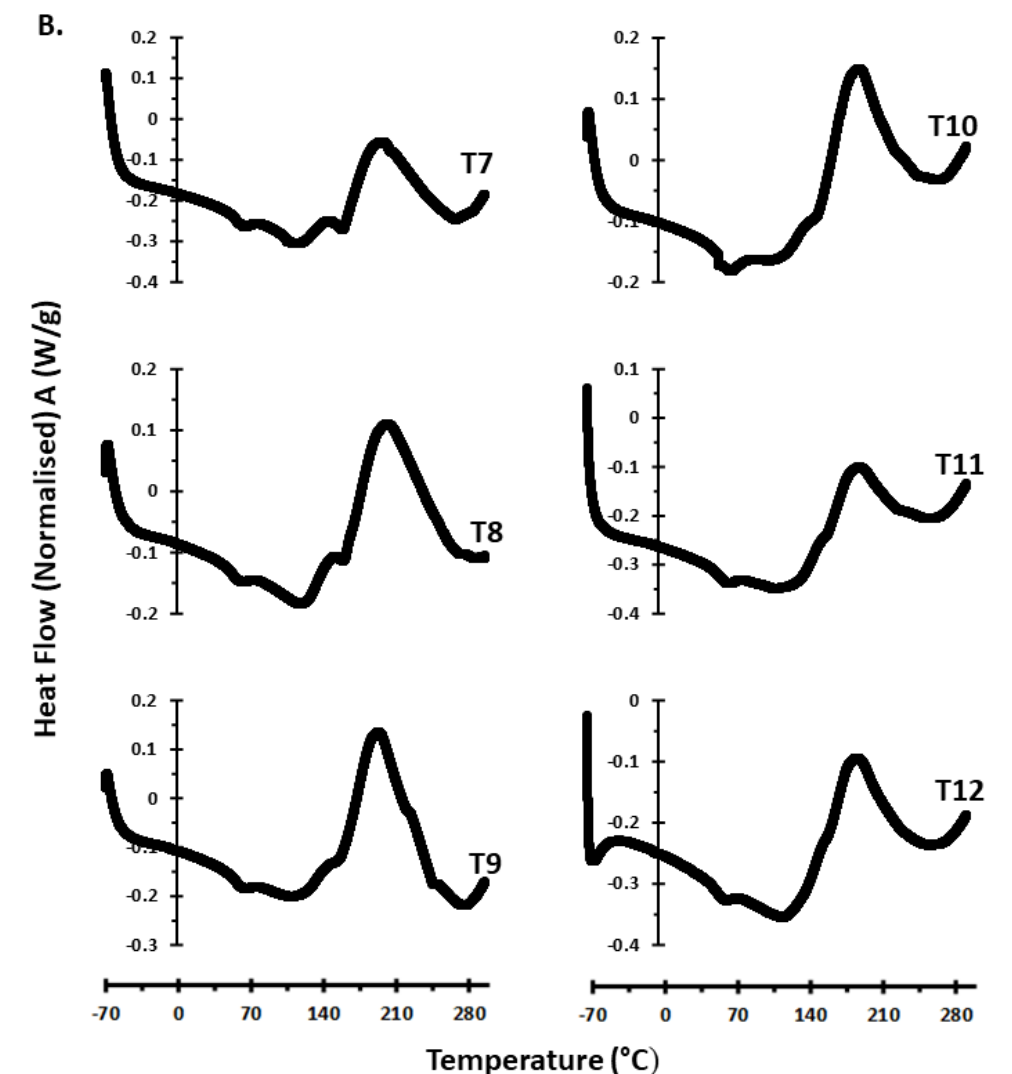
Figure 2. ( A ) Differential scanning calorimetry (DSC) thermograms of humic acid samples from soils under different organic amendments. Tn—treatment number: T1—farmyard manure (FYM, with field age of 0.5 years); T2—brown coal waste (BCW, 0.5 years); T3—biochar (BIO, 0.5 years); T4—FYM (1.5 years); T5—BCW (1.5 years); T6—BIO (1.5 years). ( B ) Differential scanning calorimetry (DSC) thermograms of humic acid samples from soils under different organic amendments. Tn—treatment number: T7—no amendment (with field age of 8 years); T8—BIO (8 years); T9—no amendment (94 years); T10—FYM + Ca (94 years); T11—no amendment (116 years); T12—FYM (116 years).